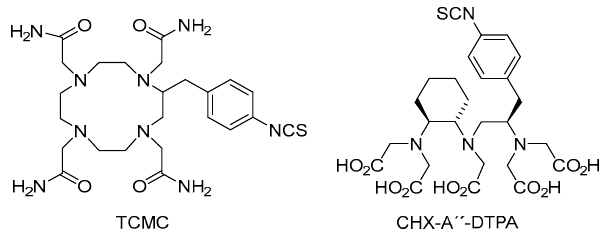
Figure 3. Chemical formulas of TCMC and CHXA”-DTPA chelators.